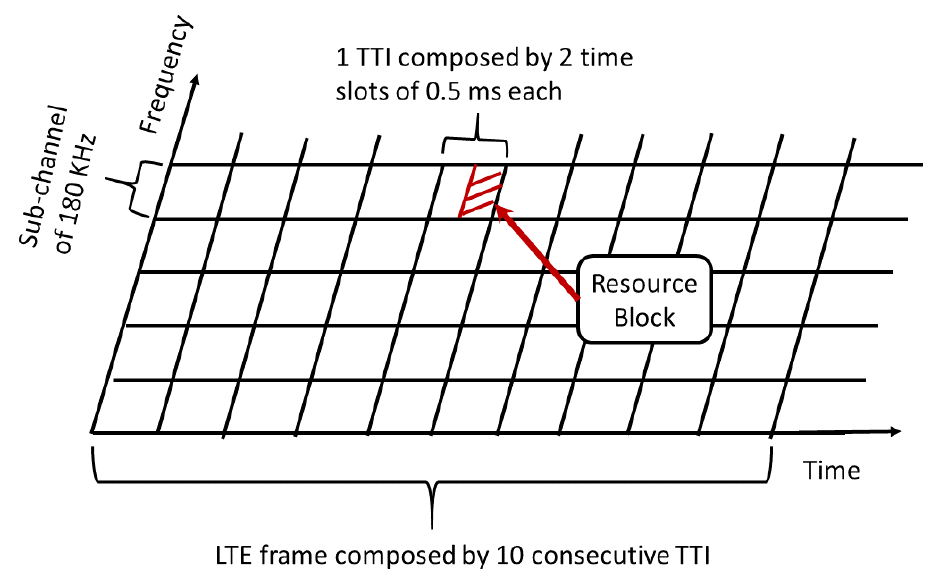
Figure 3. Time–Frequency radio resource